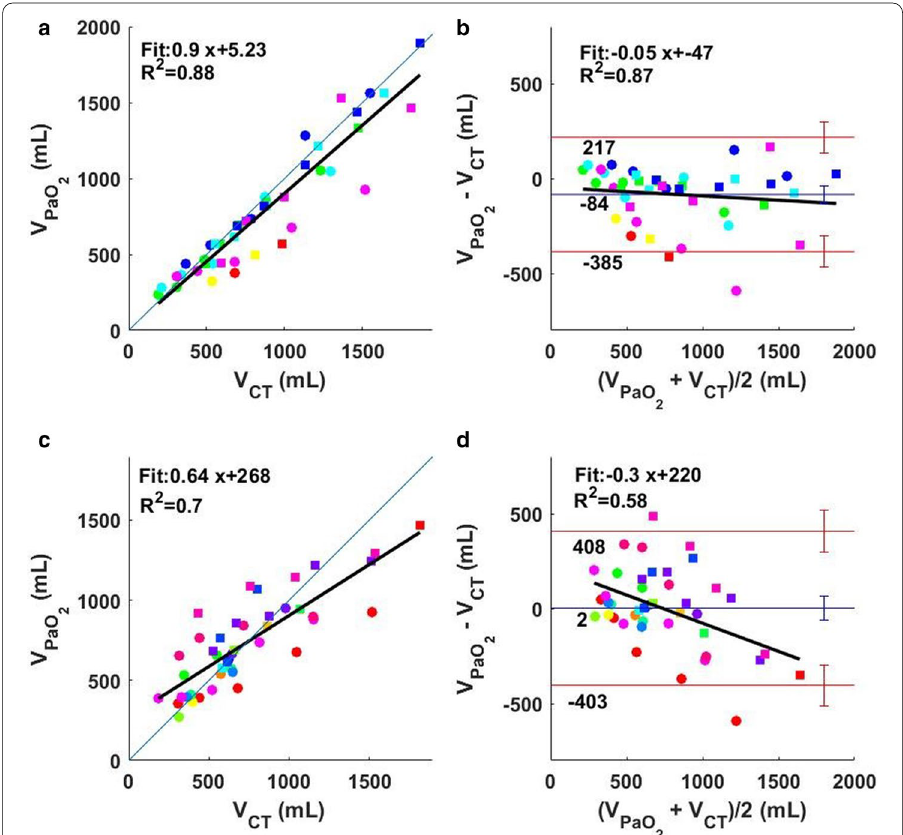
Fig. 4 Linear regression and Bland–Altman analyses for absolute volume measurements of V PaO2 and V CT in the control animals ( a , b ), and in the saline lavage lung injury model ( c , d ). Individual points represent a paired set of measurements at different PEEP levels (individual values in Additional file 1: Table S1). Each colour shows results from one animal. Circles and squares represent volumes measured, respectively, during end-expiratory and end-inspiratory apnoea. a , c Black solid lines are the regression lines, and the blue lines are the identity lines. b , d Black solid lines are the Bland–Altman plots’ regression lines, blue lines are the mean bias and red lines are the upper and lower limits of agreement ( 1.96 SD) with 95% confidence ±